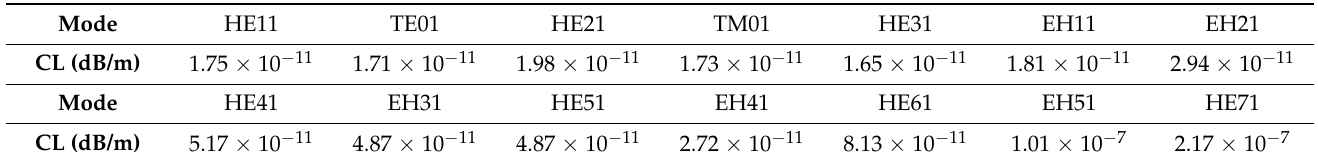
Figure 9. Dispersion as a function of frequency for different modes.